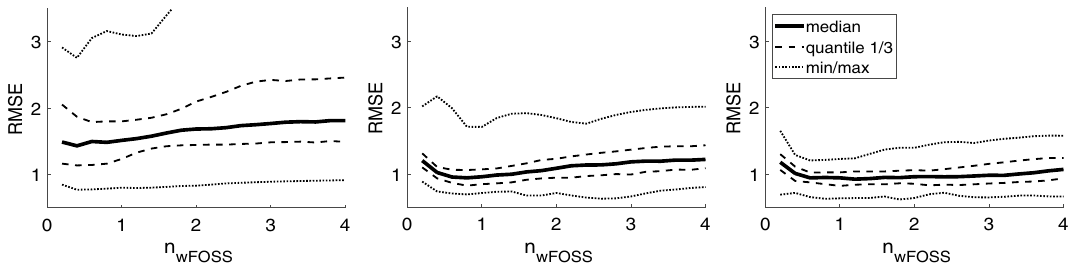
Fig. 9 Camelback function: Curves of the RMSE of 100 FOSS sampling plans as a function of the FOSS exponent n wFOSS for the RBF model with 4 (left), 9 (center), and 16 (right) sampling points